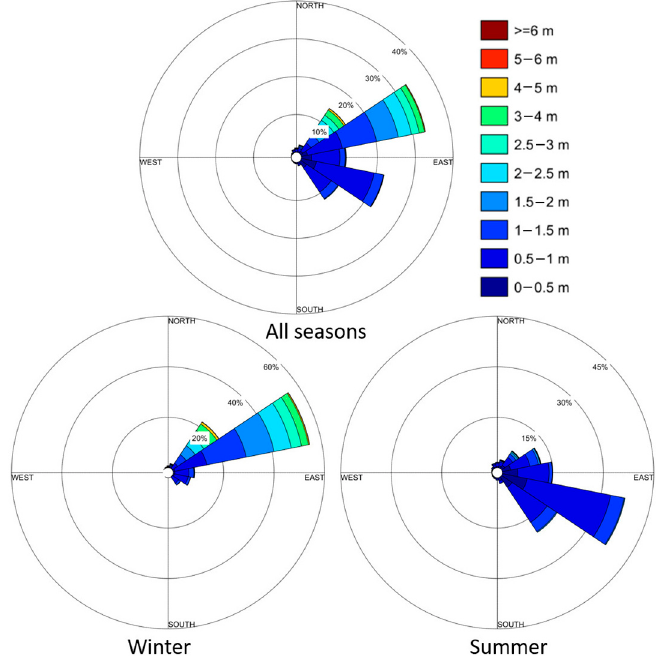
Figure 2. Re-analysis wave characteristics at point P on Figure 1 from the WAVEWATCHII data sets (source: https://polar.ncep.noaa.gov/waves/hindcasts/nopp-phase2.php, accessed on 11 April 2021) for all seasons, Winter, and Summer.